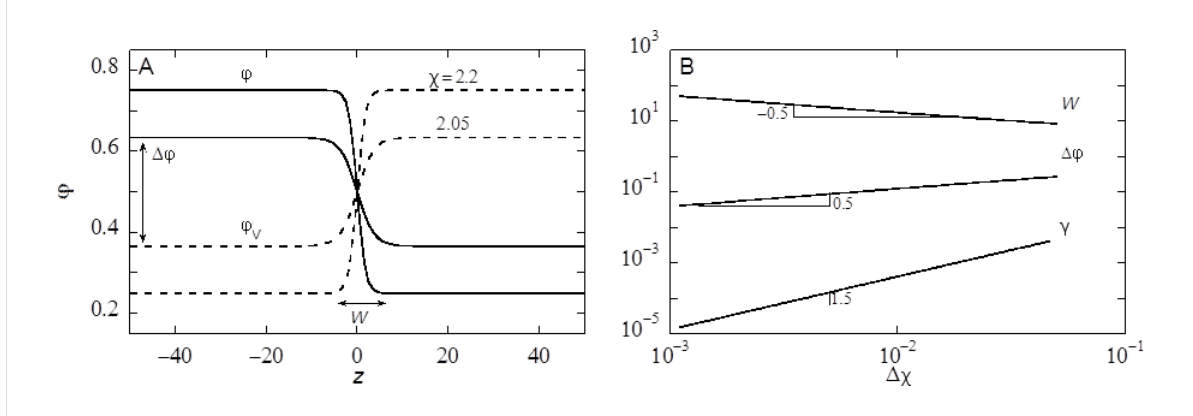
Figure 3: A) Examples of volume fraction profiles across a liquid/vapour interface found numerically by exact minimisation of Equation 6, with the interaction parameter χ = 2.05 and χ = 2.2 as indicated. B) Width of the interface (W), density difference between the two phases ( Δφ ) and dimension- less surface tension ( γ ) as function of Δχ = χ − 2 in double logarithmic